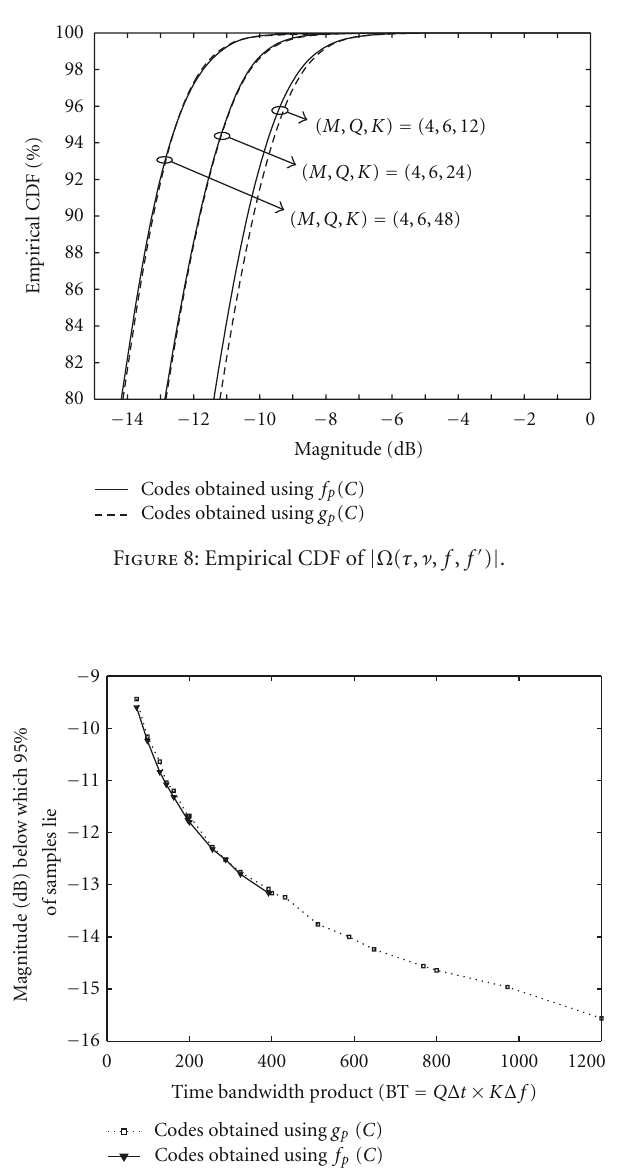
Figure 9: Magnitude of 95th percentile of | Ω ( τ , ν , f , f (cid:6) ) | .